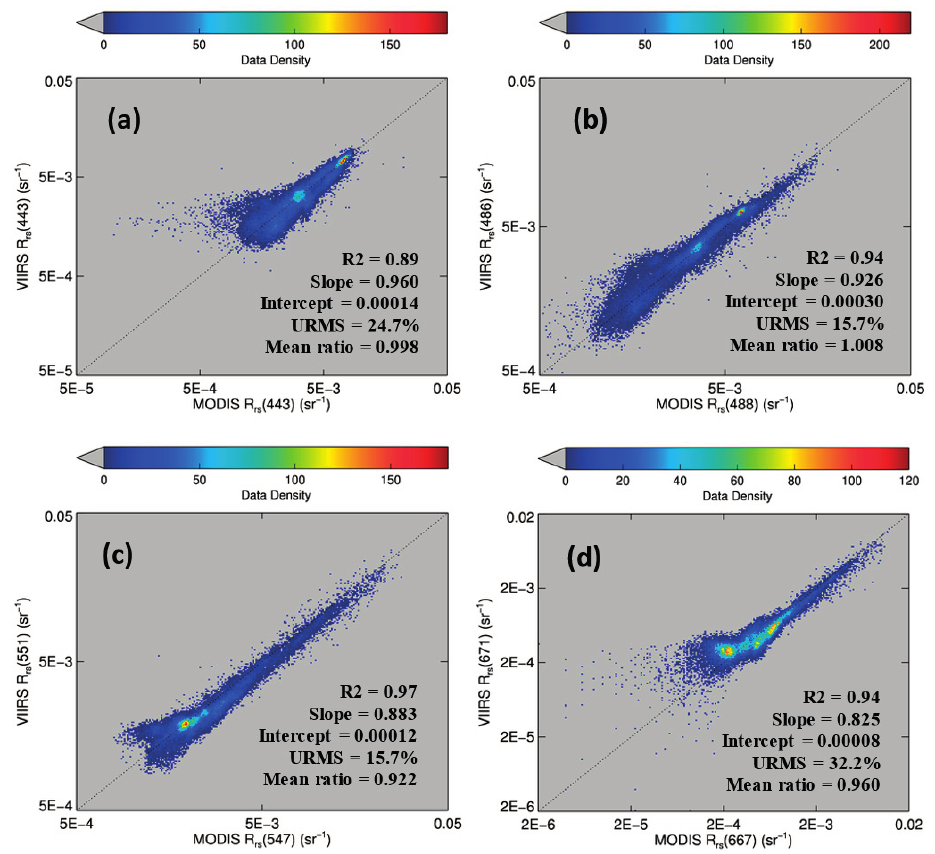
Figure 4. ( a )–( d ): Comparison between MODISA and VIIRS-derived Rrs data